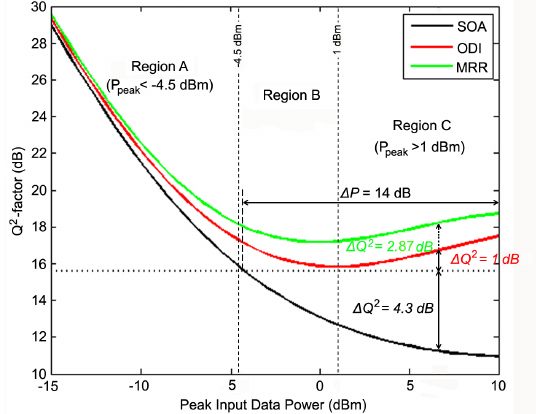
Figure 9. Q 2 -factor as a function of different peak input data powers for SOA alone (black color) and with the connection of ODI (red color) and MRR (green color). The horizontal dotted line denotes the lower limit set for the Q 2 -factor. The vertical dashed lines define the different saturation regions: A, low; B, medium; C,